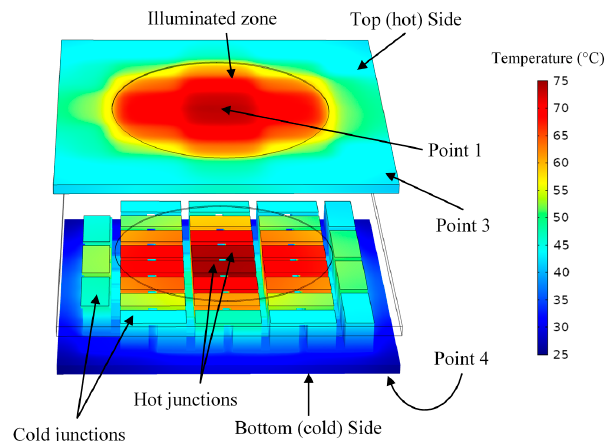
Figure 6. CFD simulation of the 3-cm TEG (sample A) operating under a concentrated light zone with a diameter of 2 cm and intensity of 12 × . Point 1 is in the middle of the TEG’s illuminated zone on the hot side; Point 2 (not shown) is opposite to Point 1 and on the cold side; Point 3 is near the hot-side edge; Point 4 is opposite to Point 3 and on the cold side.